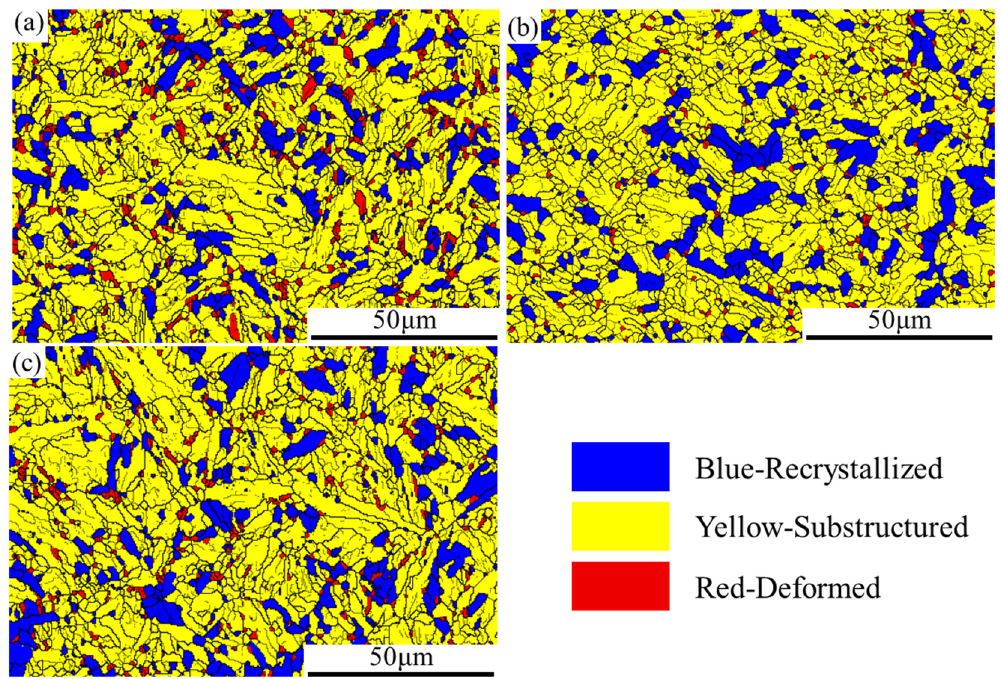
Figure 5. The EBSD maps at different compression conditions. ( a ) T = 1000 °C, 𝜀 (cid:4662) = 0.1 s − 1 ; ( b ) T = 1100 °C, 𝜀 (cid:4662) = 0.1 s − 1 ; ( c ) T = 1000 °C, 𝜀 (cid:4662) = 1 s − 1 . ( b ) T = 1100 ◦ C, . ε = 0.1 s − 1 ; ( c ) T = 1000 ◦ C, . ε = 1 s − 1